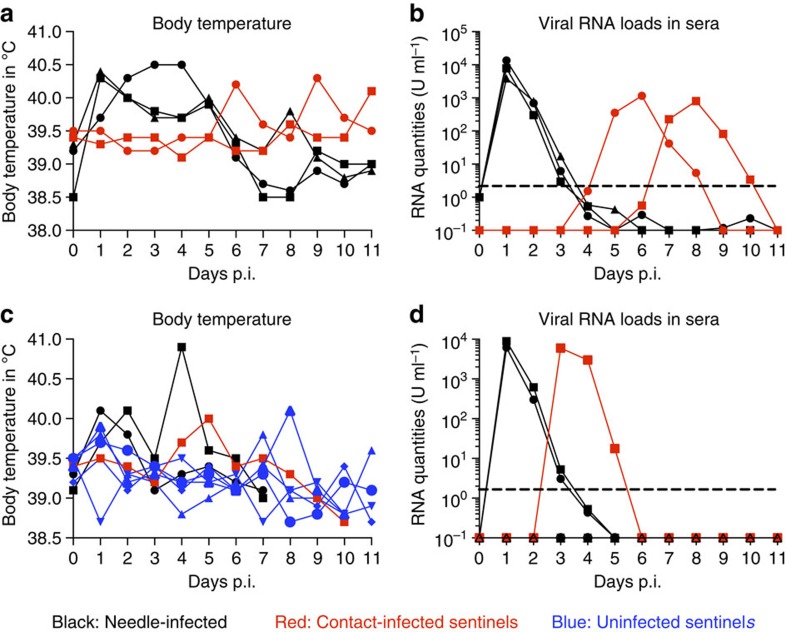
Body temperature and viraemia of pigs infected by needle or contact.(a,b) Three needle-infected pigs (107 TCID50 per pig, black lines) were housed with two naive sentinel animals (red lines). (c,d) Two animals were needle-infected (black) and housed with six sentinel pigs (red and blue). Viraemia is shown as viral RNA loads determined by real-time RT–PCR, and expressed as U ml−1 (1 U corresponding to the RNA quantity found in 1 TCID50 of a virus stock).